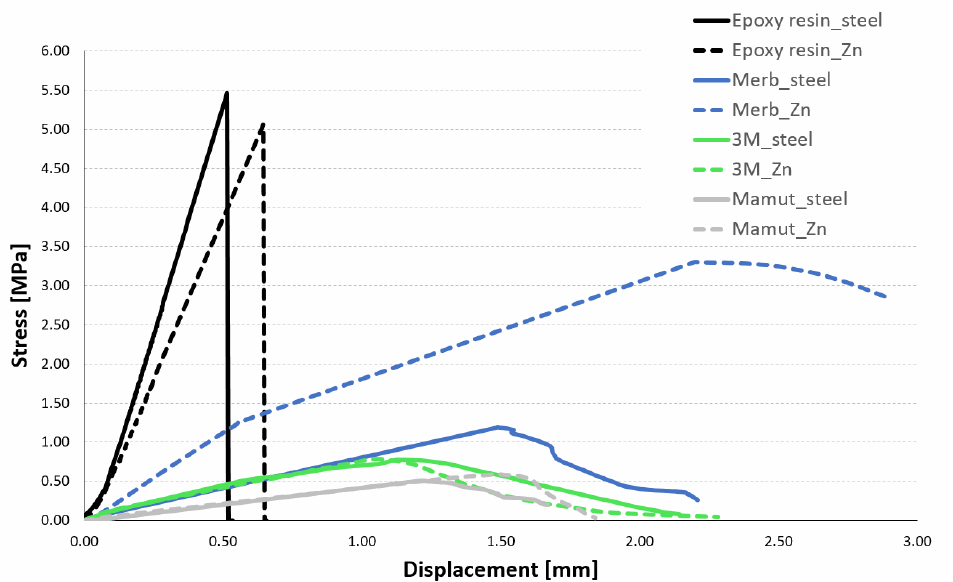
Figure 4. Addiction stress – displacement, shear